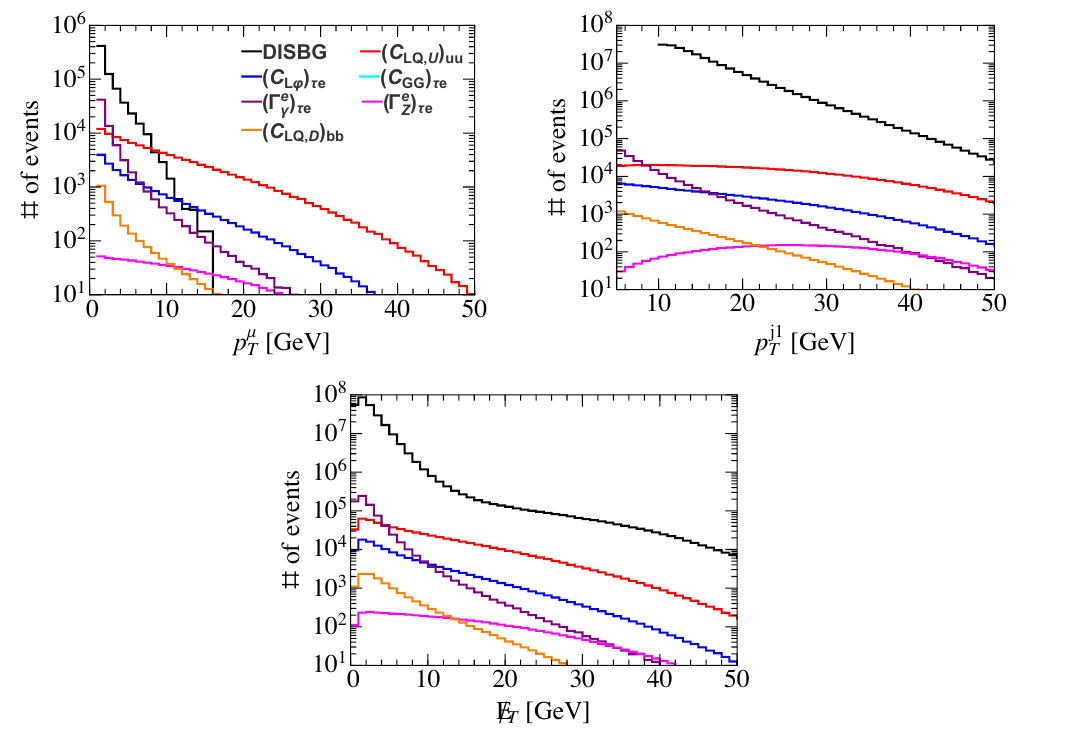
and 6 E from ep → τ ( → µ ¯ ν , p j 1 T √ T T S = 141 GeV) and L = 100 fb − 1 . The Wilson coefficients of the = 1 . i